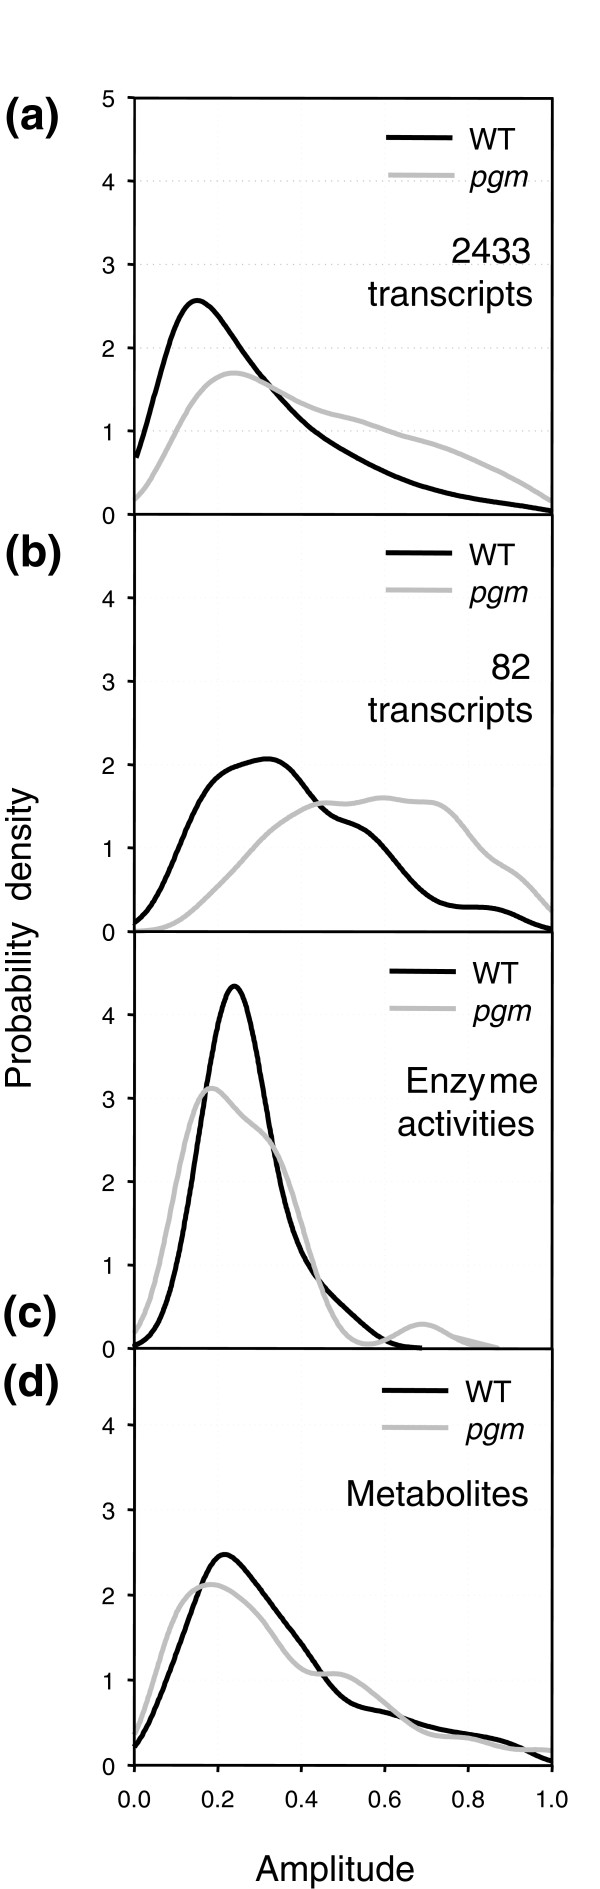
Distribution of amplitudes of diurnal changes in transcripts, metabolites and enzyme activities. Distribution of amplitudes of diurnal changes in (a) 2,433 transcripts assigned to metabolism, (b) the subset of 82 transcripts encoding the enzymes measured, (c) 23 enzyme activities, and (d) 137 metabolites. Distributions are expressed as probability densities and were calculated with R using the function 'density', which computes kernel density estimations. The same bandwidth of 0.06 was used for all datasets.